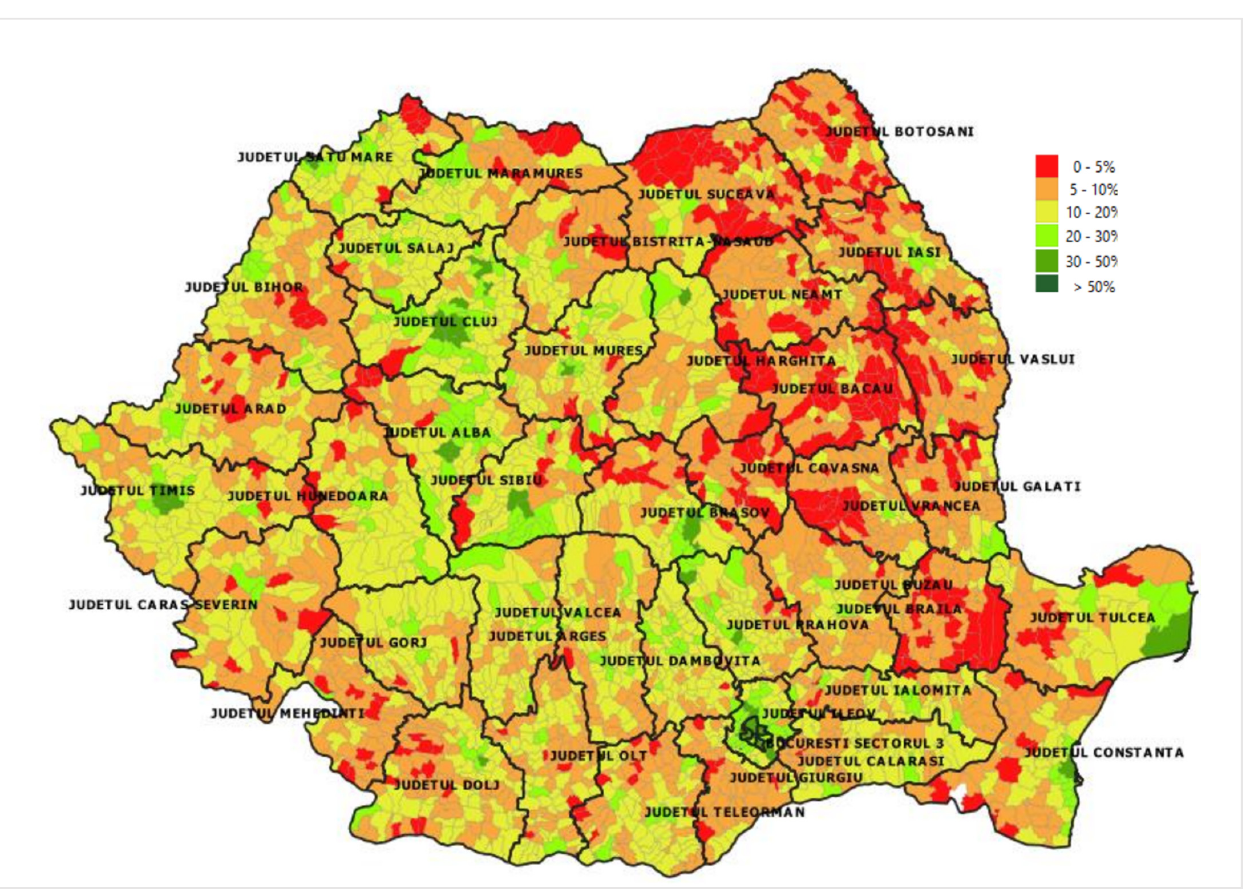
Figure 6. Distribution of administered doses by age group, Romania, 27 December 2020–31 De- cember 2021.